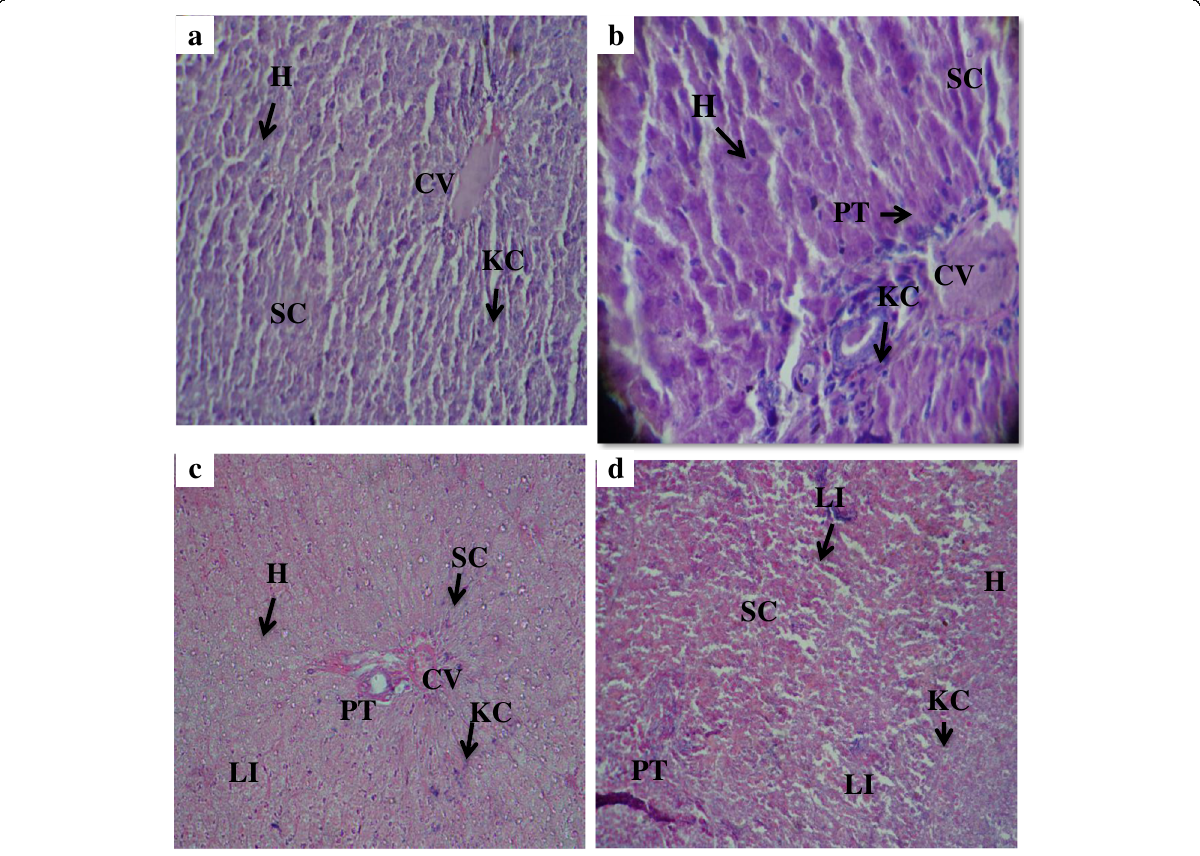
Fig. 1 Liver histological sections of rats in sub-acute toxicity study. a Normal control group; b 10 mg/kg BA-treated group; c 10 mg/kg UA-treated group; d 50 mg/kg APAP-treated group (× 25, H&E stained). CV — central vein, PT — portal triard, SC — sinusoidal congestion, H — histiocytes, KC — Kupffer cell, LI — leucocytic